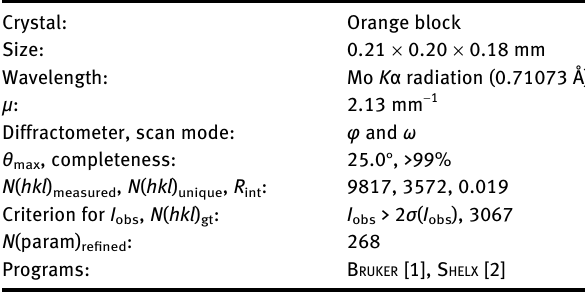
Table  : Data collection and